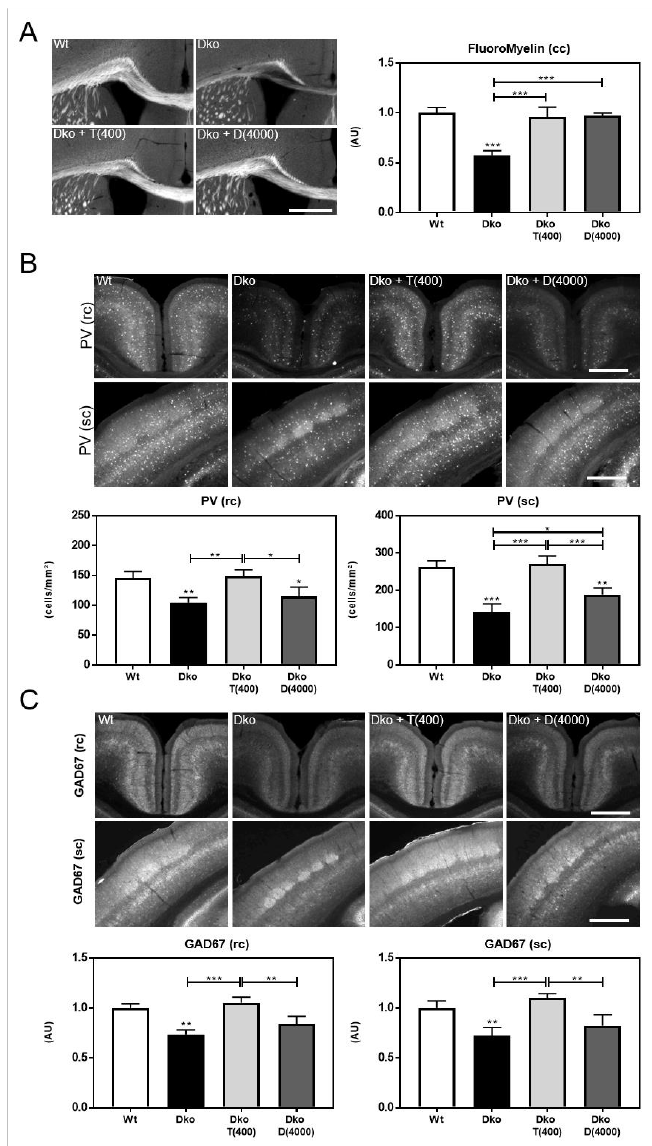
Figure 4. Long-term morphological alterations are induced by early postnatal TH-analog application. Following transient treatment with TH analogs Triac and Ditpa (in ng/g bw) between P1 and P20, brain parameters were examined at 10 weeks of age. ( A ) Myelination was evaluated in the corpus callosum (cc) by FluoroMyelin staining. TH-analog treatment could rescue the hypomyelination phenotype of Dko mice. ( B ) PV+ interneurons were visualized in the retrosplenial cortex (rc) and somatosensory cortex (sc). PV cell numbers were low in saline injected Dko animals, but fully restored in both areas upon Triac treatment. Ditpa only mildly improved PV+ numbers in the sc. ( C ) GAD67 immuno-reactivity analyzed in the same cortical regions demonstrated reduced integrated densities in saline injected Dko mice that was unaffected by Ditpa, but fully restored by Triac application. n = 3 – 4. Scale bars 500 µm (FluoroMyelin), 250 µm (PV, GAD67). *, p < 0.05; **, p < 0.01; ***, p < 0.001.